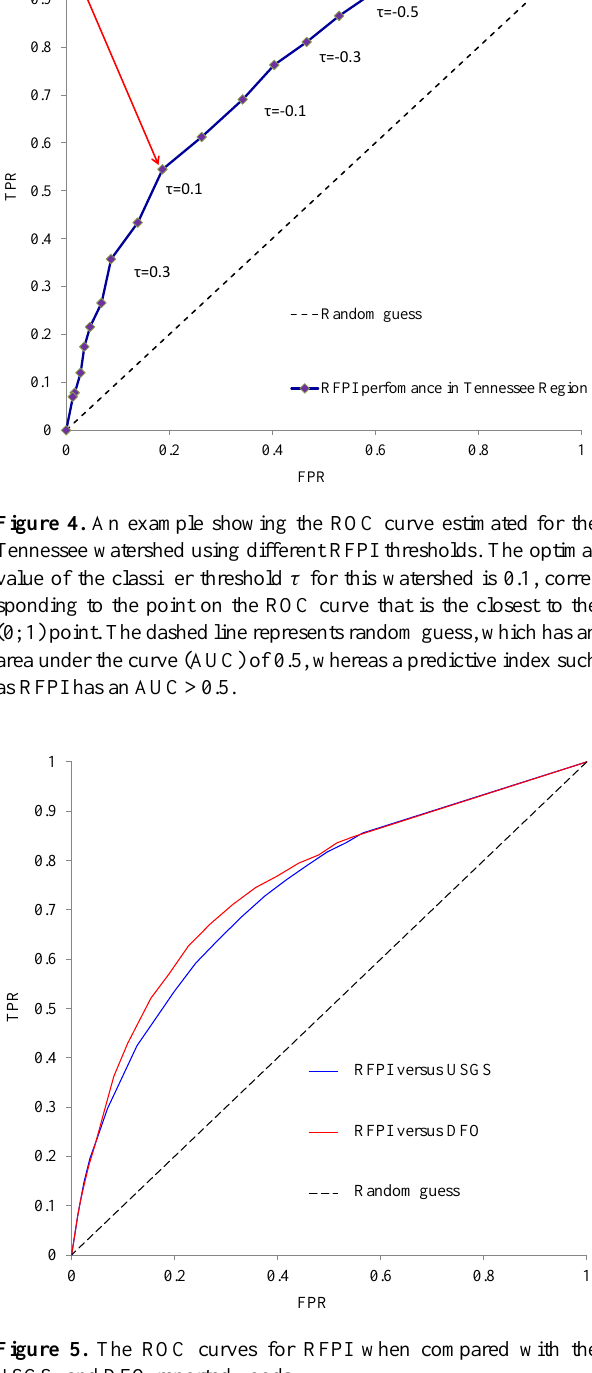
have different shapes and the optimal RFPI threshold varies between − 0.4 and 0.1 for different watersheds. The RFPI skill also varies with the seasons (Fig. 7). For example, in the larger Mississippi watershed (consisting of Upper and